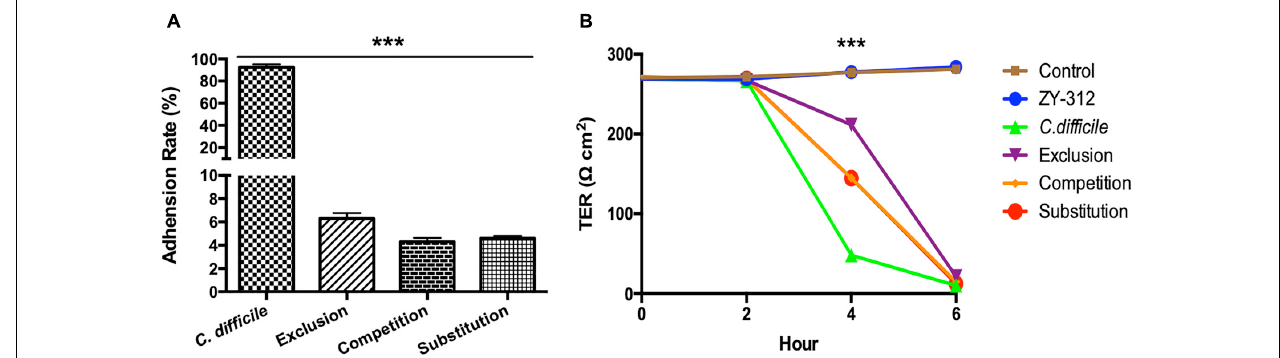
FIGURE 4 | Bacteroides fragilis ZY-312 inhibits C. difficile adherence and improves TEER. (A) Adherence to HT-29 cells in C. difficile , Exclusion, Competition and Substitution groups. C. difficile group, 1 × 10 5 HT-29 cells were infected with 1 × 10 7 cfu C. difficile ; Competition group, 1 × 10 5 HT-29 cell were co-infected with 1 × 10 8 cfu B. fragilis and 1 × 10 7 cfu C. difficile ; Exclusion group, cells were infected with B. fragilis for the first hour and C. difficile added for the second hour; Substitution group, C. difficile were added for the first hour and B. fragilis added for the second hour. The cells were incubated at 37 ◦ C under anaerobic conditions for 2 h in total. (B) Transepithelial electrical resistance (TEER) values for Caco-2 cells in Control, B. fragilis ZY-312, C. difficile , Exclusion, Competition and Substitution groups. Control group, 2 × 10 4 Caco-2 cells were cultured without treatment. ZY-312 group, cells were incubated with 3 × 10 7 CFU B. fragilis ZY-312. C. difficile group, cells were incubated with 3 × 10 6 CFU C. difficile . Competition group, cells were co-infected with 3 × 10 7 CFU B. fragilis and 3 × 10 6 CFU C. difficile . Exclusion group, B. fragilis infected cells for the first hour and C. difficile for the second hour; Substitution group, C. difficile infected cells for the first hour and B. fragilis for the second hour. Data are shown as means ± SEM. ∗∗∗ p < 0.001 by